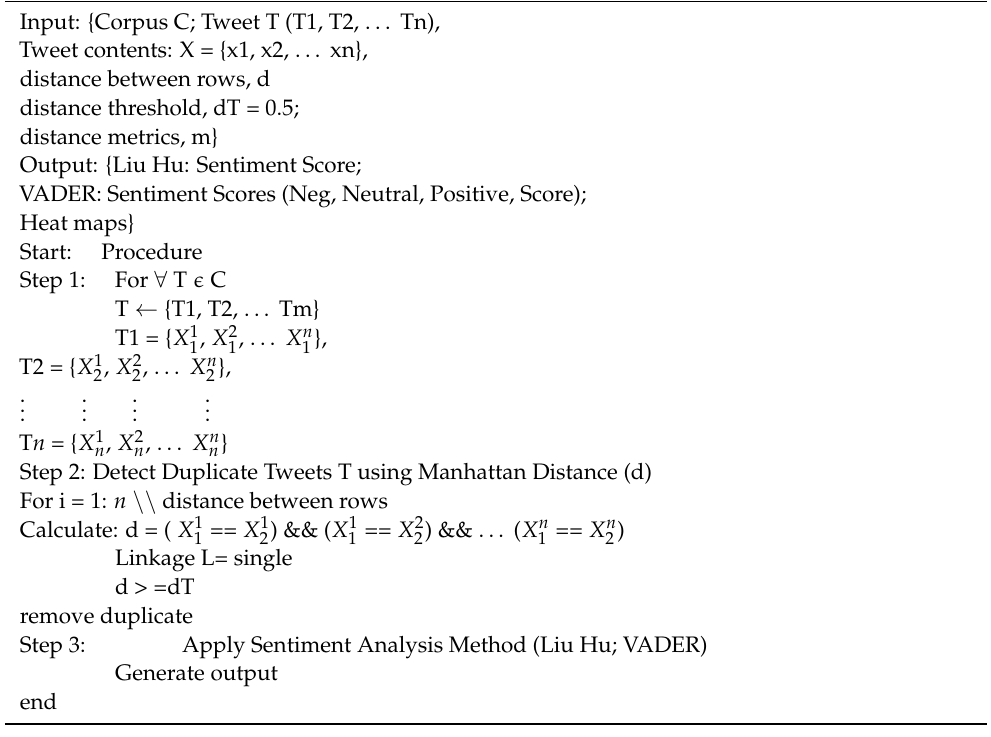
Algorithm 1: Duplicate Detection and Sentiment Analysis